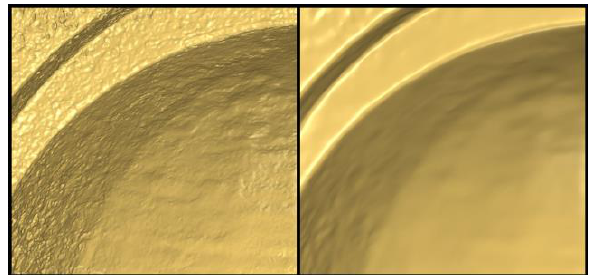
Figure 7. On the left: mesh (automatically generated) with topological errors. On the right: final mesh after editing operations.